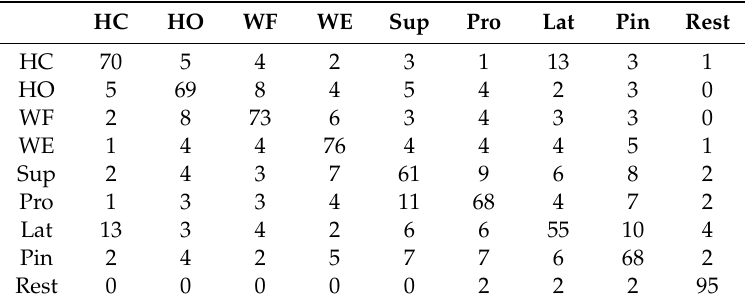
Table 5. Confusion matrix based on within-session calibration (the mean across the two days have been calculated) using a CNN. All values are in percent and presented as the mean across participants. HC (Hand Close), HO (Hand Open), WE (Wrist Extension), WF (Wrist Flexion), Sup (Supination), Pro (Pronation), Lat (Lateral Grasp), and Pin (Pinch